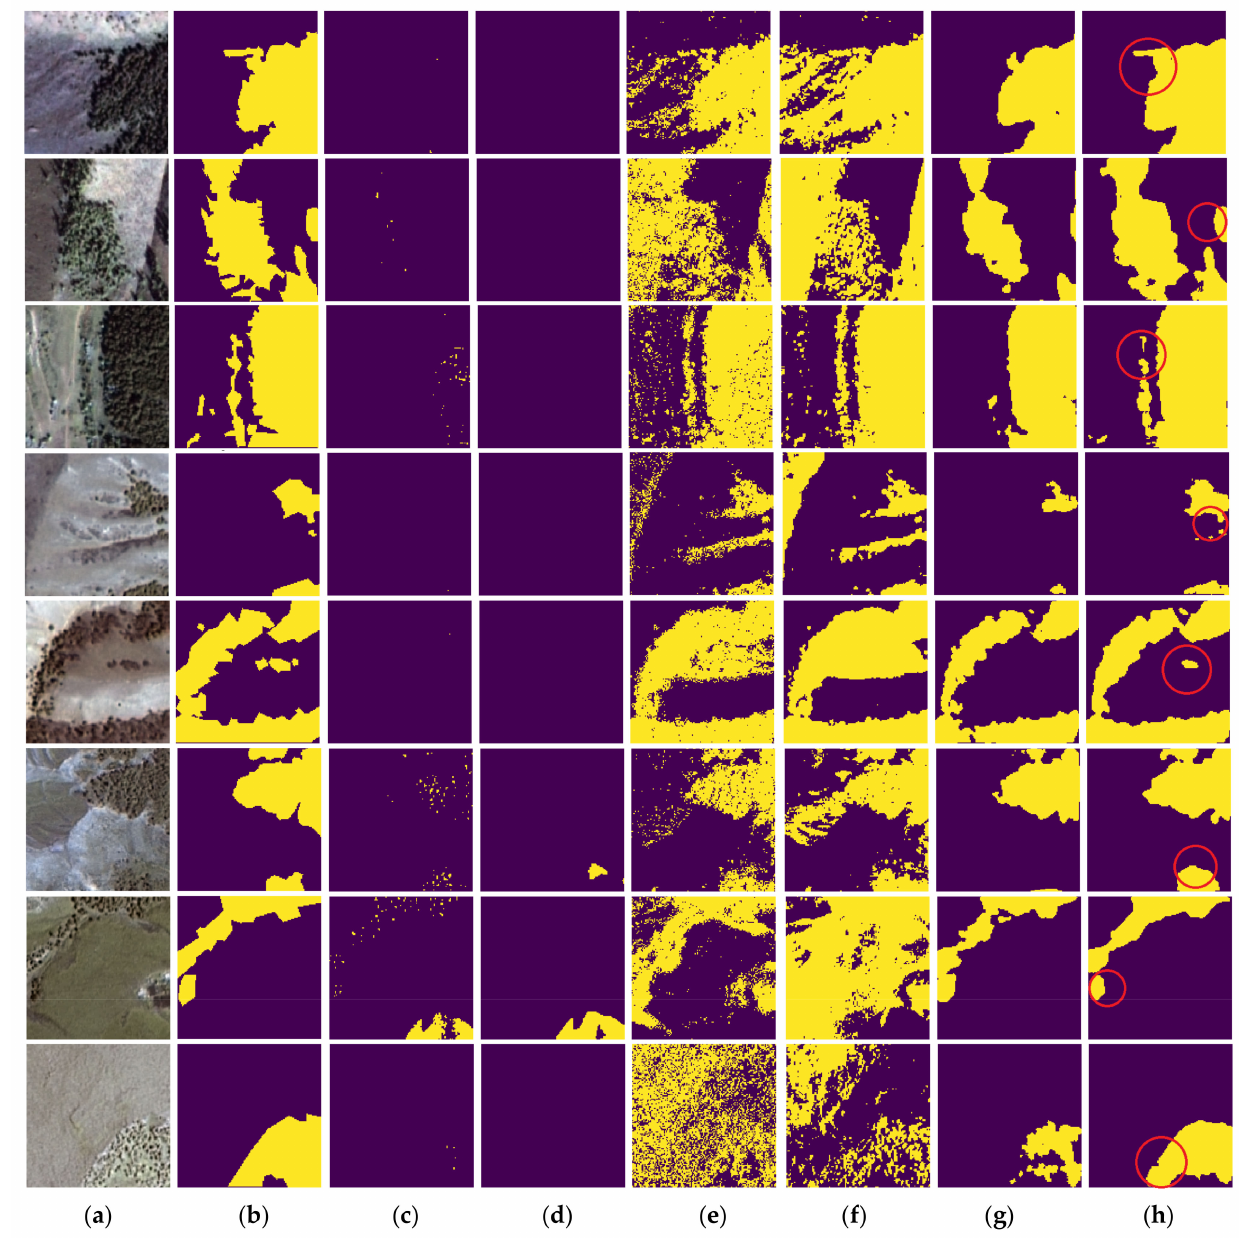
Figure 12. Comparison of segmentation results for the proposed method and other methods: ( a ) test sample’s false color composite image; ( b ) test sample’s ground truth; ( c ) normalized difference vegetation index (NDVI); ( d ) ratio vegetation index (RVI); ( e ) random forest (RF); ( f ) support vector machine (SVM); ( g ) UNET; ( h ) proposed method. Each row represents a test sample visualization and model segmentation, the samples are ordered based on the follow steps: we randomly select 2 test samples during the 100, 300, 500, 700 training sample models testing process, thus the first two rows of this figure represents two samples from the 100 training sample models testing process, and the rest are from the 300, 500, 700 training sample models testing process. The red circle within each row of column ( h ) represents the significant segmentation result improvement of the proposed method, while being compared with other state-of-the-art